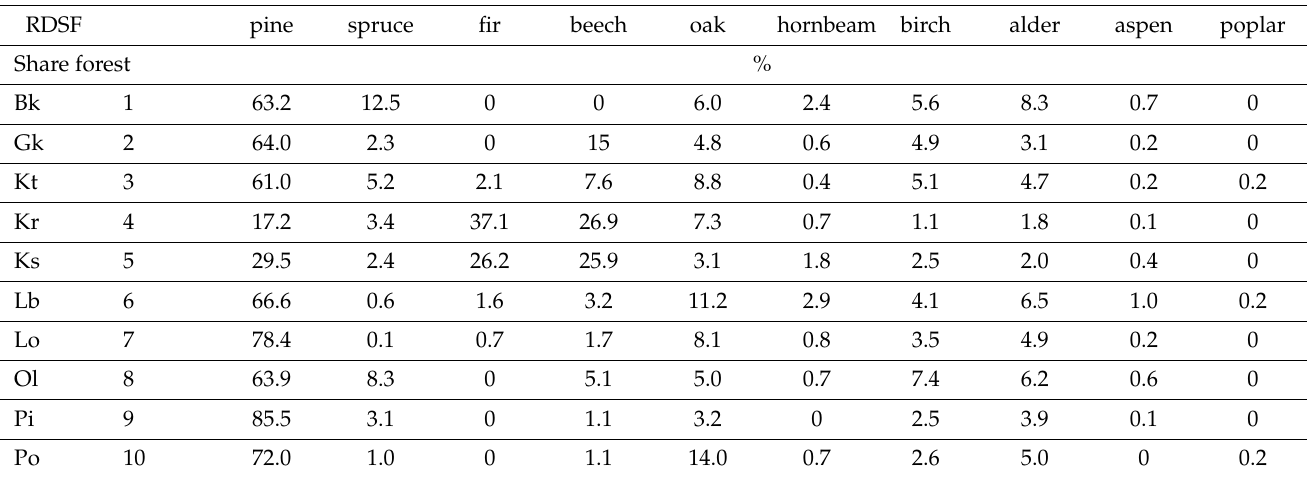
Table 2. Adopted structure of the basic share of the occurrence of species in the area of timber resources under the management of RDSF